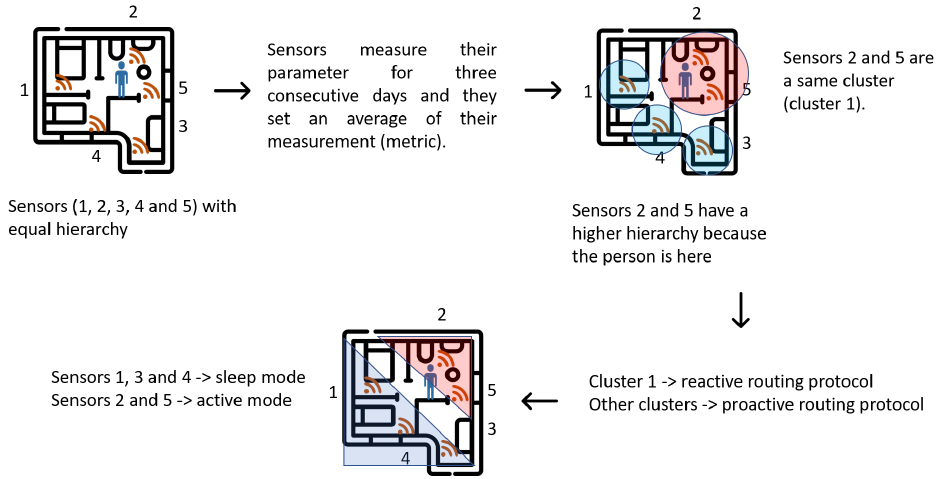
Figure 4. Sensor operation by hierarchies according to activity of person in